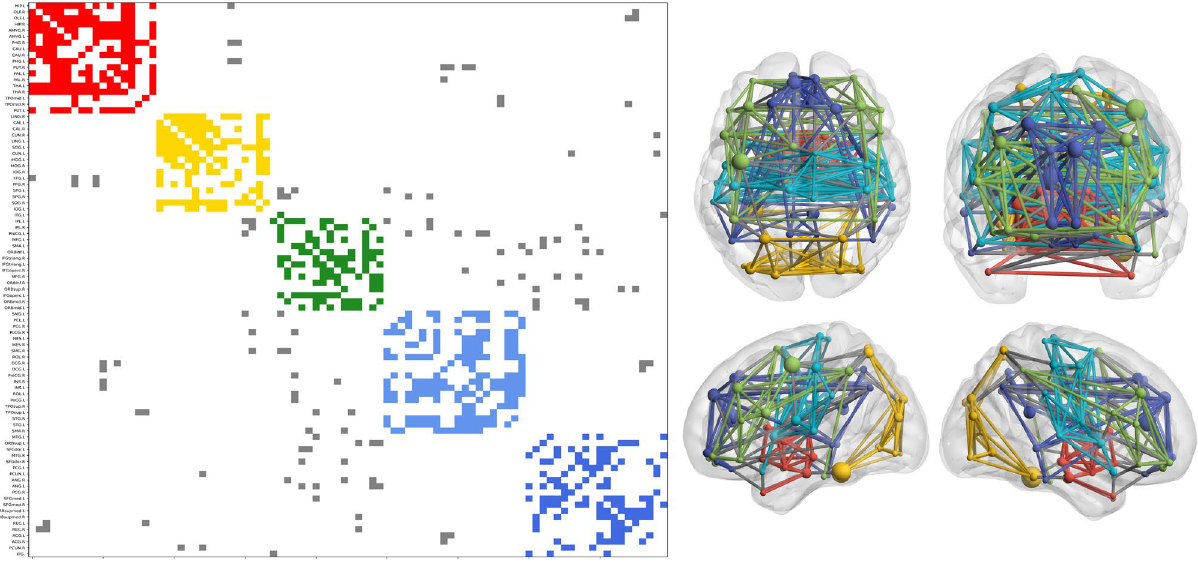
Figure 4. Graph partitioning of the communities defined by using QA for the AAL atlas. Left: Reordered connectivity matrix according to module assignment. Right: Axial, coronal, and 2 hemispheres sagittal views of brain connectivity (plotted using the BrainNet Viewer Toolbox 36 ). In both cases, connections and nodes belonging to the same community are plotted using the same color code while grey edges correspond to connections between different modules. The size of the nodes is given by the degree.